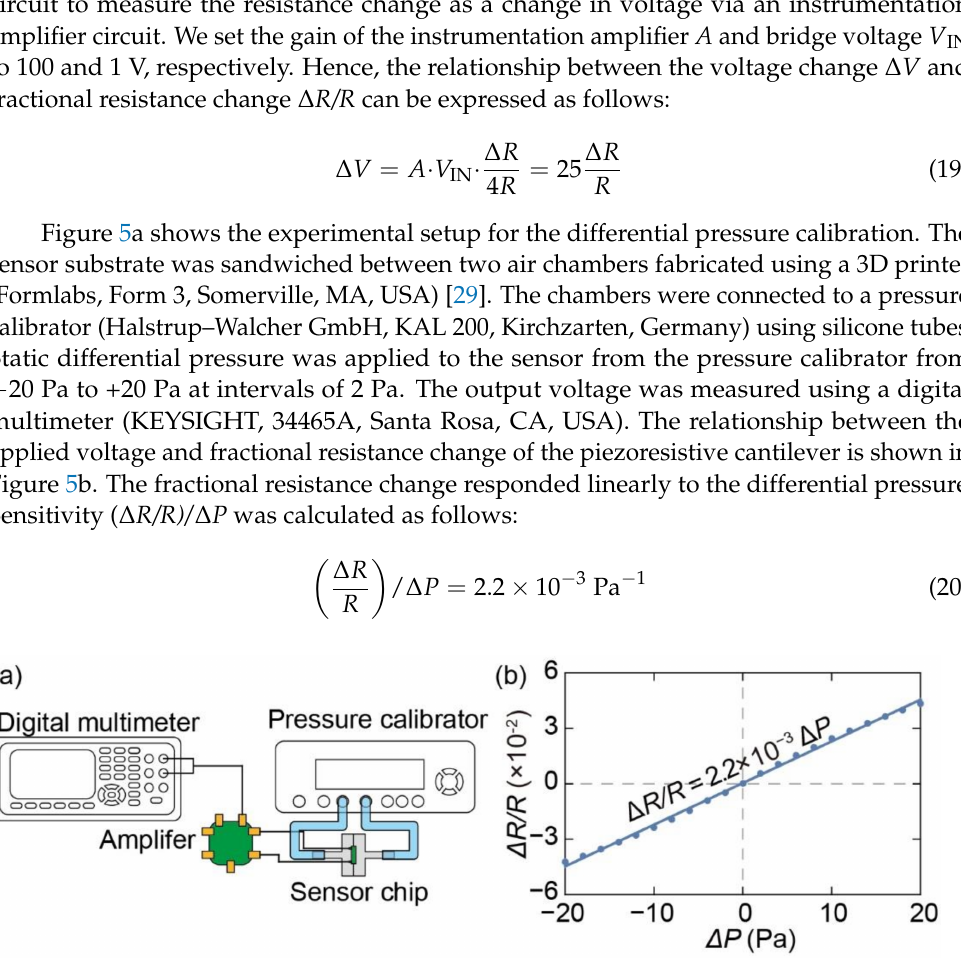
Figure 5. ( a ) Method of calibrating piezoresistive cantilever against differential pressure. ( b ) Relationship between differential pressure and fractional resistance